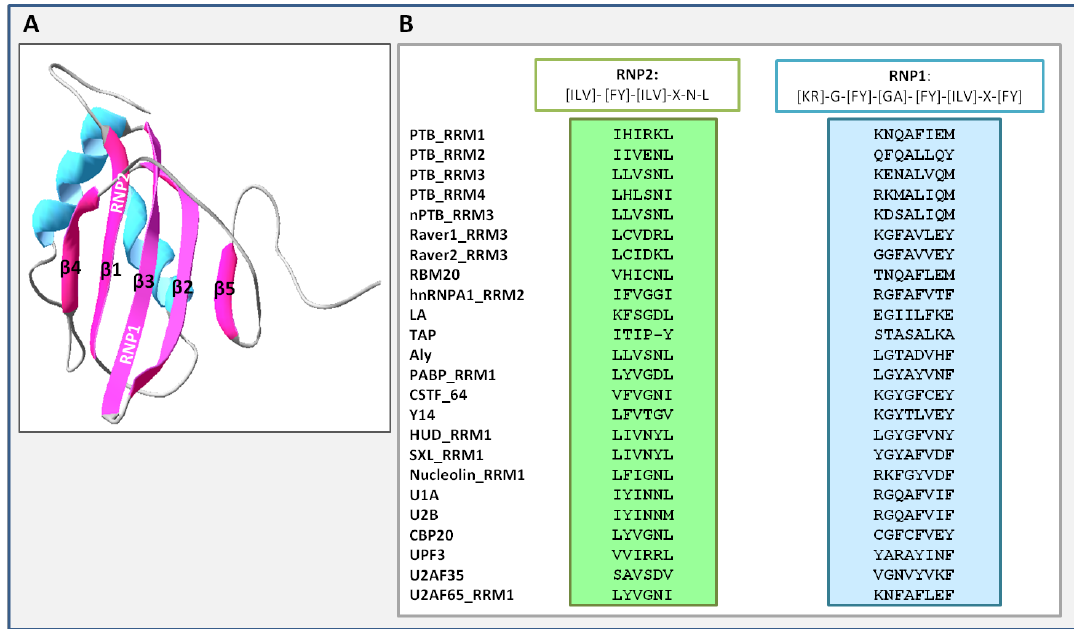
Figure 2. PTB RRM3 structure. ( A ) The PTB RRM3 structure was obtained with Swiss-PdbViewer (http://www.expasy.org/spdbv/); ( B ) Alignments of ribonucleoprotein (RNP) 2 and RNP1 sequences present in the PTB RRM3 with RRM containing